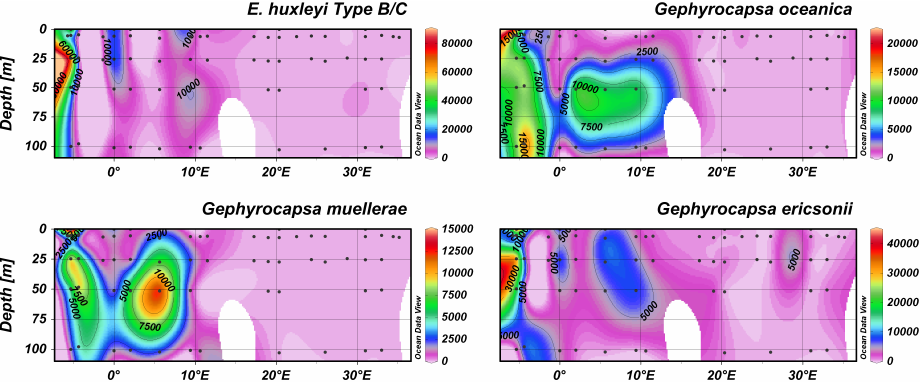
Figure 7. Distribution, along a west–east transect, of the heterococcolithophore species forming the cluster comprised mainly of “western Mediterranean species” (the transect includes the stations labeled in black in Figure 1).